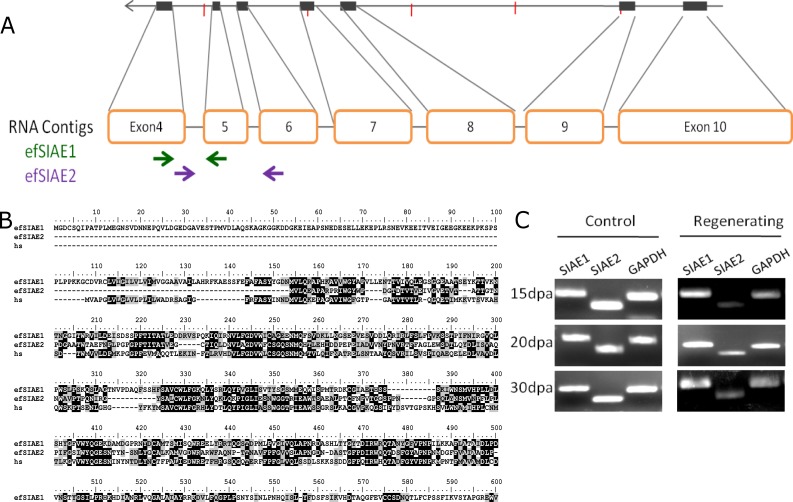
Divergent expression of O-sialic acid esterase homologs during regeneration of E.fetida: (A) Gene structure of efSIAE1. Paralog specific primers for efSIAE1 and efSIAE2 are shown by green and purple arrows respectively. (B) Two contigs derived from de novo assembly of RNA-Seq data showed homology at protein level to O-sialic acid esterase gene of human (hs). One of them was also identified in a scaffold assembled in the genome sequence assembly. (C) RT-PCR using gene specific primers confirmed the divergent expression of the transcripts of efSIAE1 and efSIAE2 in the RNA-Seq data.